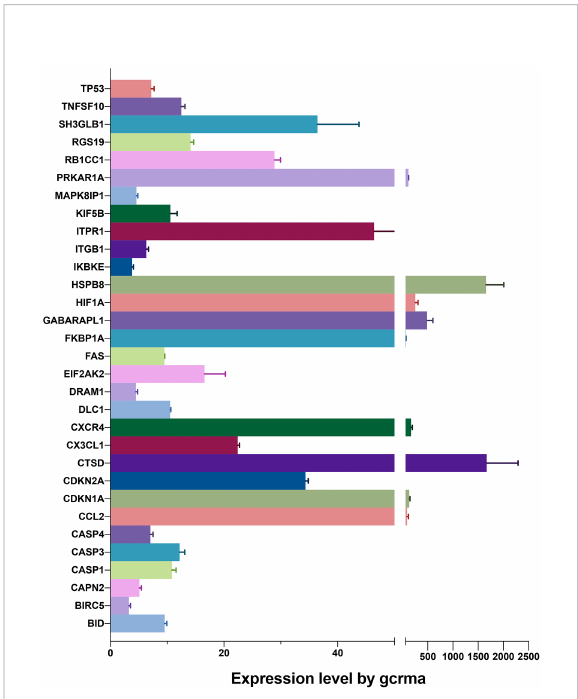
FIGURE 3 Expression levels of differentially expressed genes identi fi ed by BioGPS in retinal